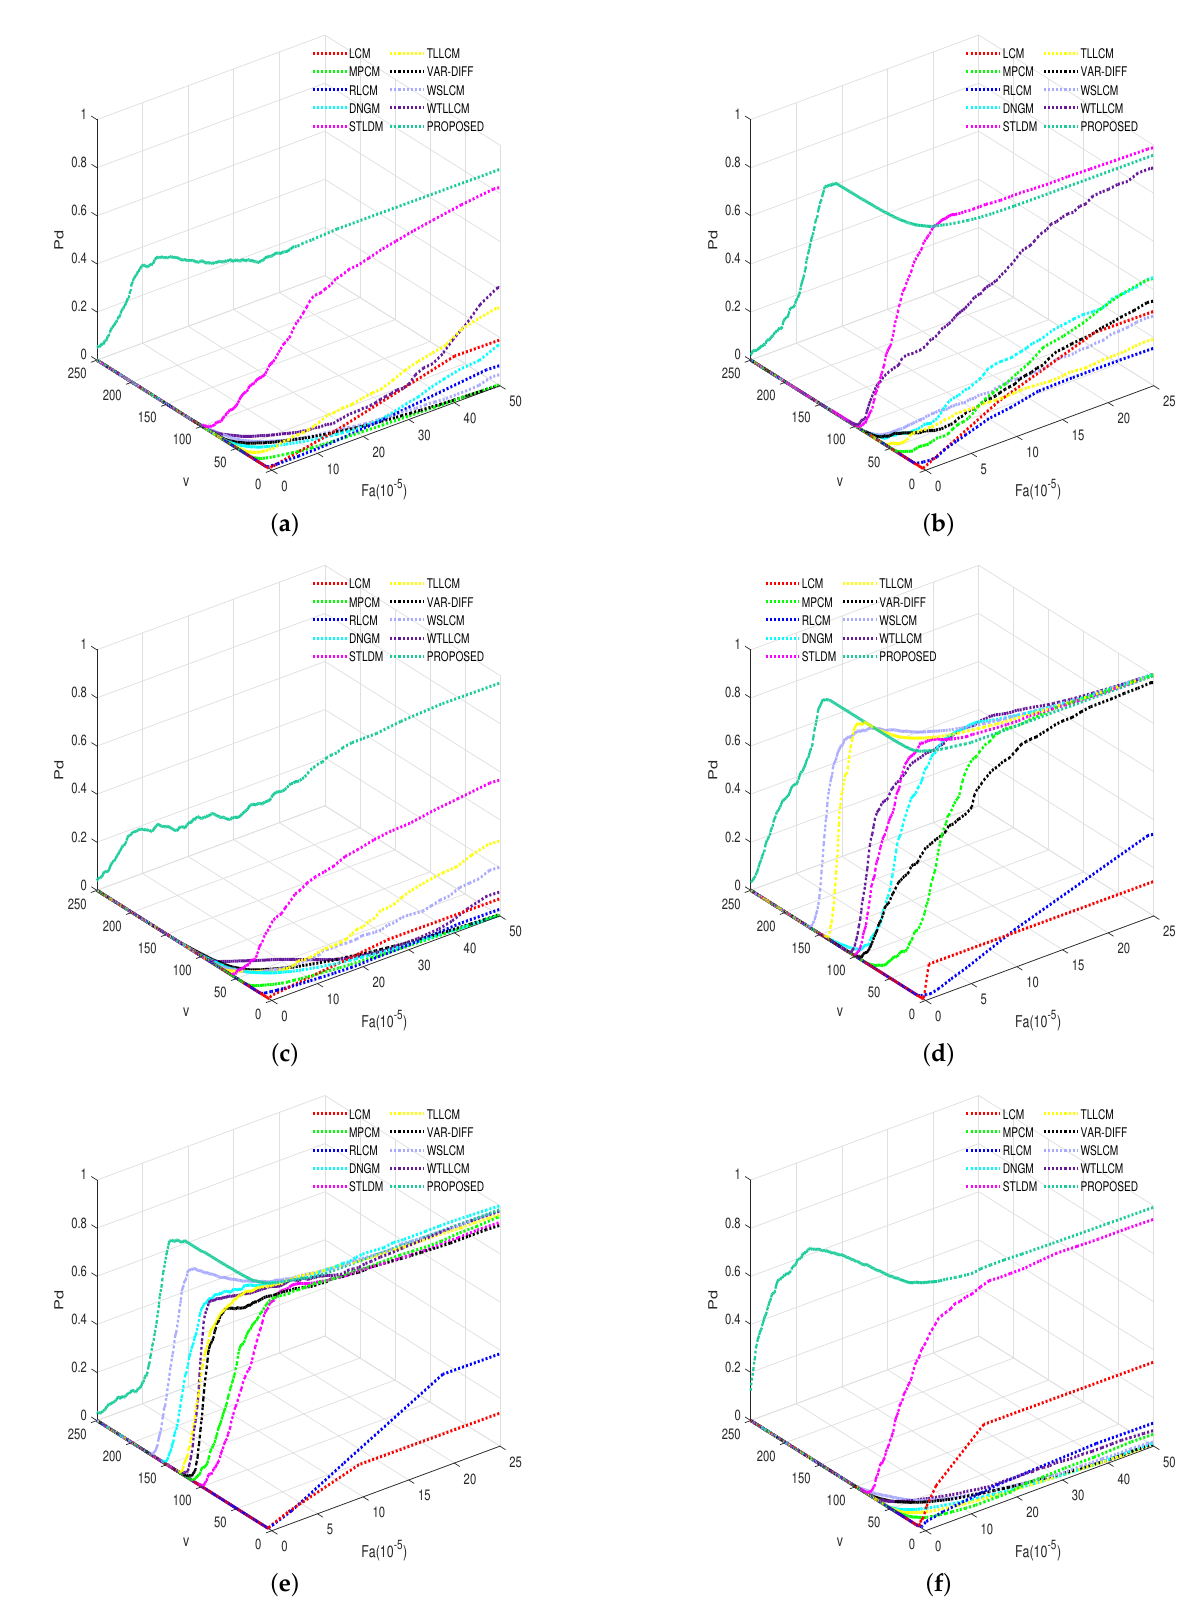
Figure 21. 3-D ROC curves of different methods on data. ( a – f ) are the curves of data1-data6. Curves in different colors are the results of different